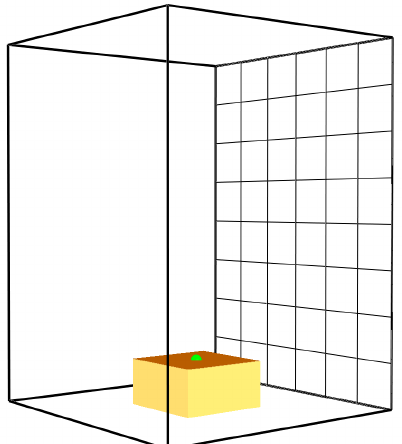
Figure 1. Geometrical representation of the improved Simple Cone Calorimeter (SCC) simulation setup in Smokeview. Darker area represents the model of the cable sample. Was also utilised for the Micro-Combustion Calorimetry (MCC) simulations.